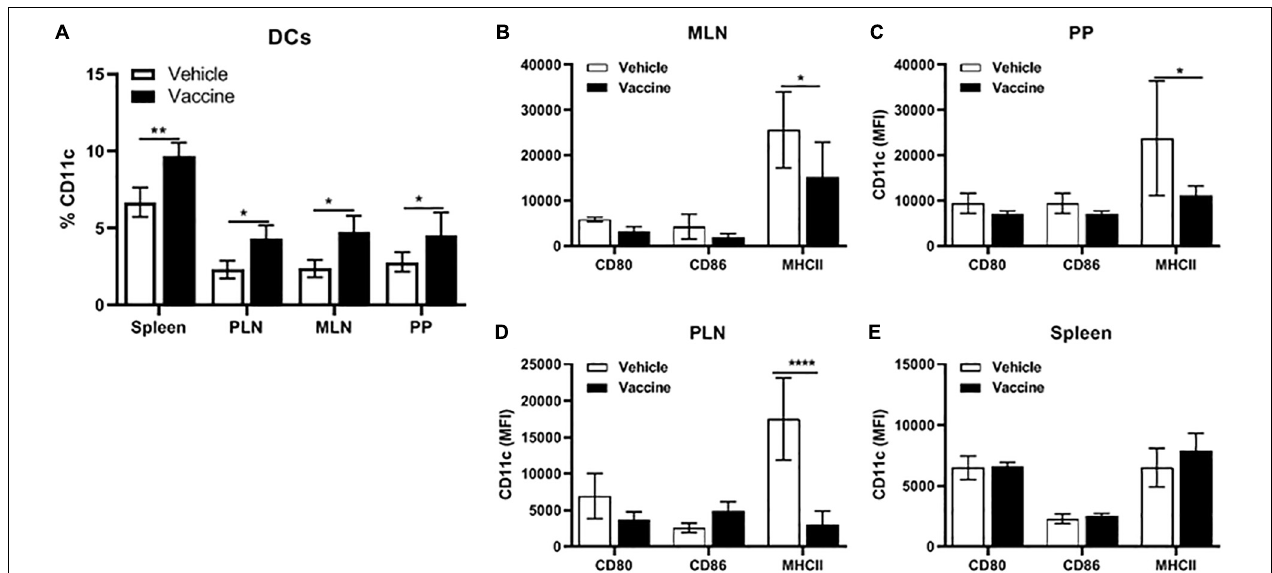
FIGURE 6 | A Salmonella -based vaccine increase DCs in lymphoid organs. NOD mice were injected with 2.5 µ g/mouse of anti-CD3 mAb for 5 days followed by 2 doses of oral vaccine containing PPI + TGF β + IL10 ( n = 5). Four weeks post-vaccination, DCs were analyzed in different organs by FACS analysis. (A) Quantification of the percentage of CD11c + in total live cells of the spleen, PLN, MLN, and PP. (B) MLN, (C) PP, (D) PLN, and (E) spleen expression of CD80, CD86, and MHCII was measured in DCs from each organ. The data shown are the average with SD from two independent experiments. Statistical analysis using two-way ANOVA shows significance between vaccine and vehicle treated groups (* p < 0.05, ** p < 0.01, **** p <